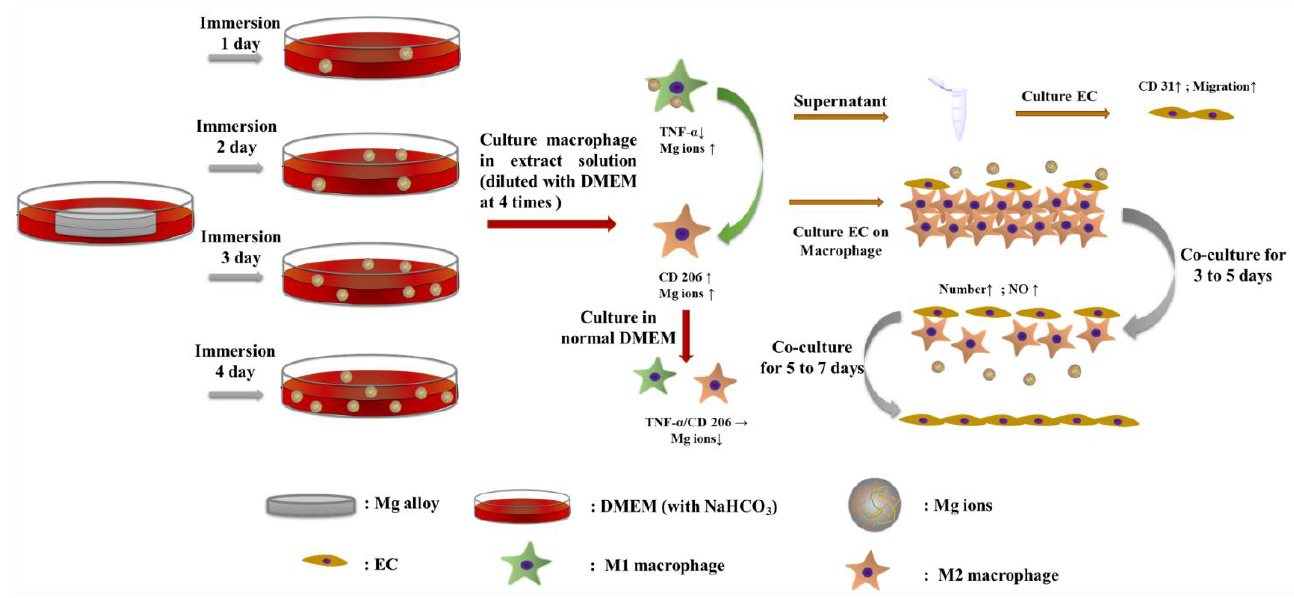
Figure 5. Mg alloy degradation products that regulate macrophages and EC behaviors [104].